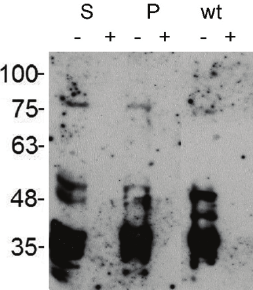
Figure 3. Western blot of S2 cell lysates, immunostained with non-sulfated HNK1-epitope specific